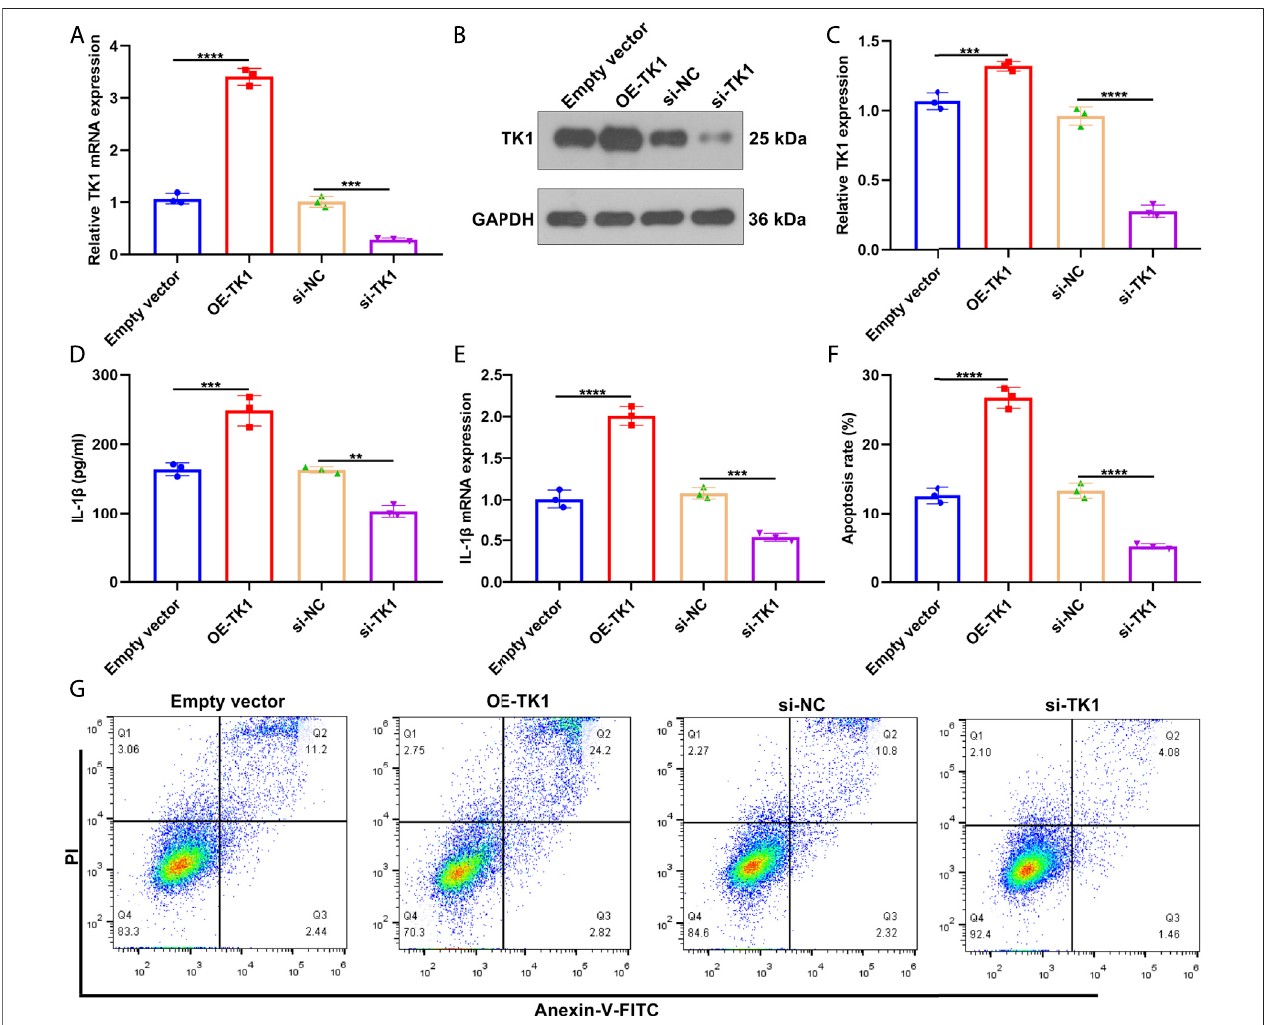
FIGURE 8 | Silencing TK1 relieves in fl ammatory response and apoptosis in SLE BMSCs. (A) TK1 mRNA expression was measured in SLE BMSCs with TK1 overexpressionorTK1knockdownthroughRT-qPCR. (B,C) TK1proteinexpressionwastestedinSLEBMSCswithTK1overexpressionorTK1knockdownviawestern blotting. (D) IL-1 β levels were quanti fi ed in the supernatant of speci fi ed SLE BMSCs through ELISA. (E) RT-qPCR was adopted to measure the mRNA expression of IL- 1 β in speci fi ed SLE BMSCs. (F,G) Flow cytometry analyses were conducted to test the apoptosis levels of speci fi ed SLE BMSCs. ** p < 0.01; *** p < 0.001; **** p <